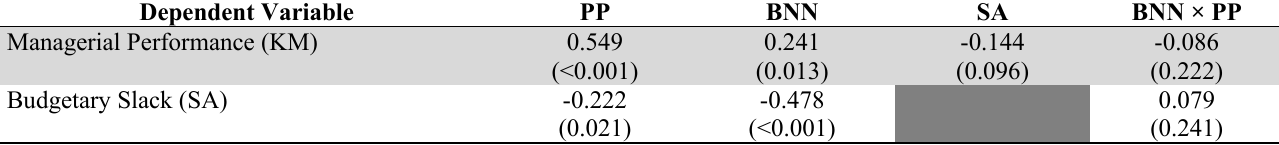
The results of p-values